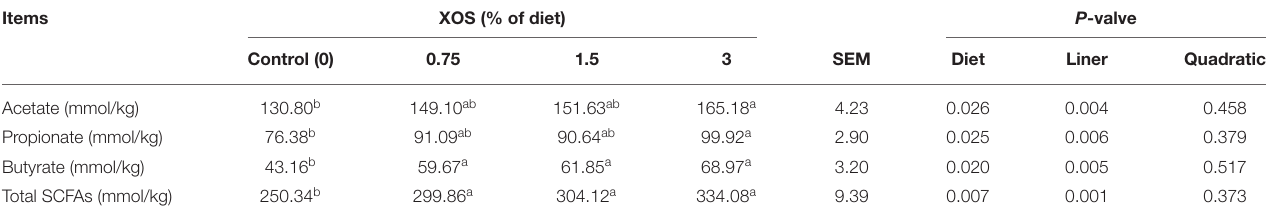
TABLE 8 | The effects of dietary supplementation with XOS on SCFAs concentration in feces of weaning piglets. Items XOS (% of diet) P -valve Control (0) Diet Liner